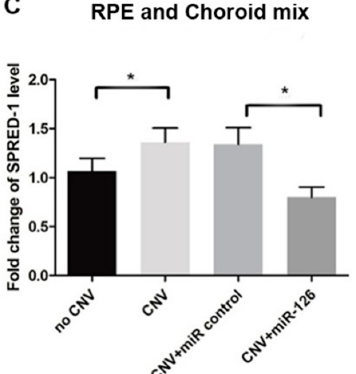
Figure 2. mRNA expression of miR-126 target genes in the eyes of CNV mice. VEGF-A , KDR and SPRED-1 mRNA expression in the eye tissue of control mice either transfected with a miR-control or a miR-126 mimic through an intravitreal injection: ( A ) relative VEGF-A mRNA expression; ( B ) relative KDR mRNA expression; and ( C ) relative SPRED-1 mRNA expression. Data are presented as mean fold change of mRNA levels ± SD, n = 12, * p < 0.01.